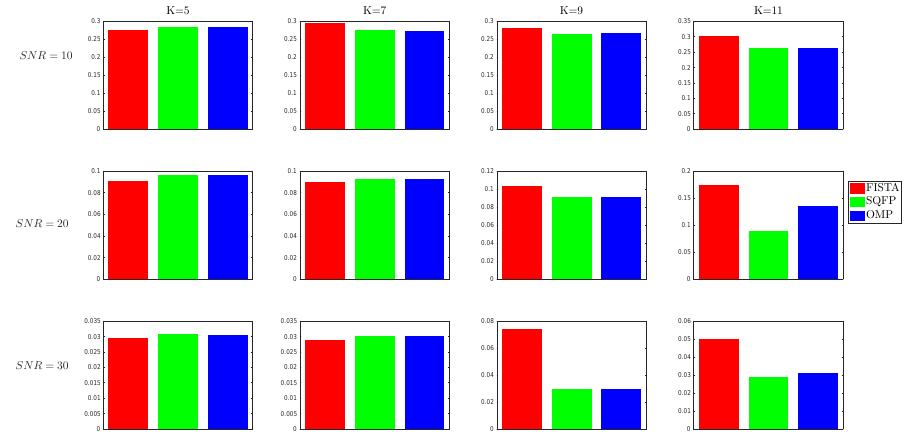
Figure 7. Mean errors for all algorithms, dictionary size 80 × 200, condition number 100,000.